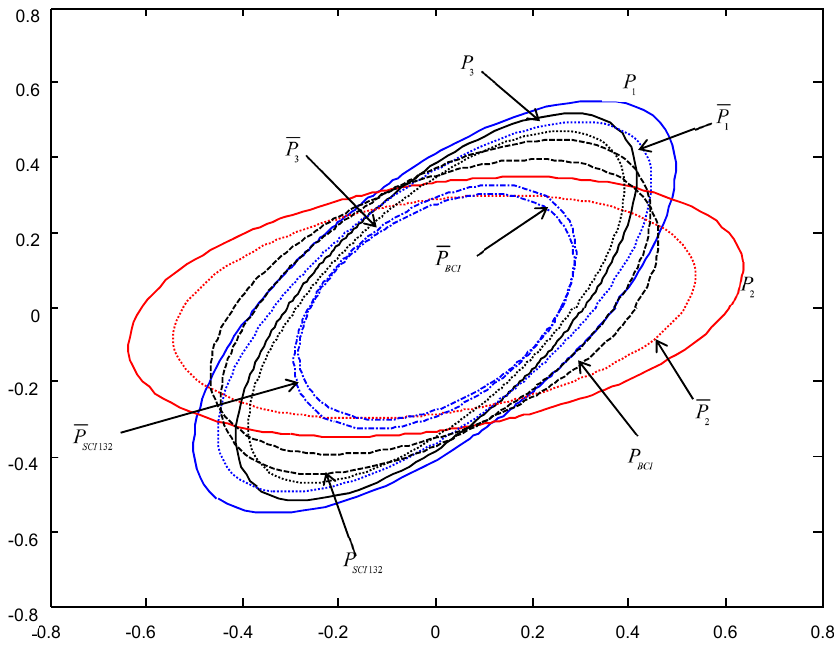
Figure 7. The ellipses of the actual and conservative steady-state filtering error variances of the order 132 SCI .